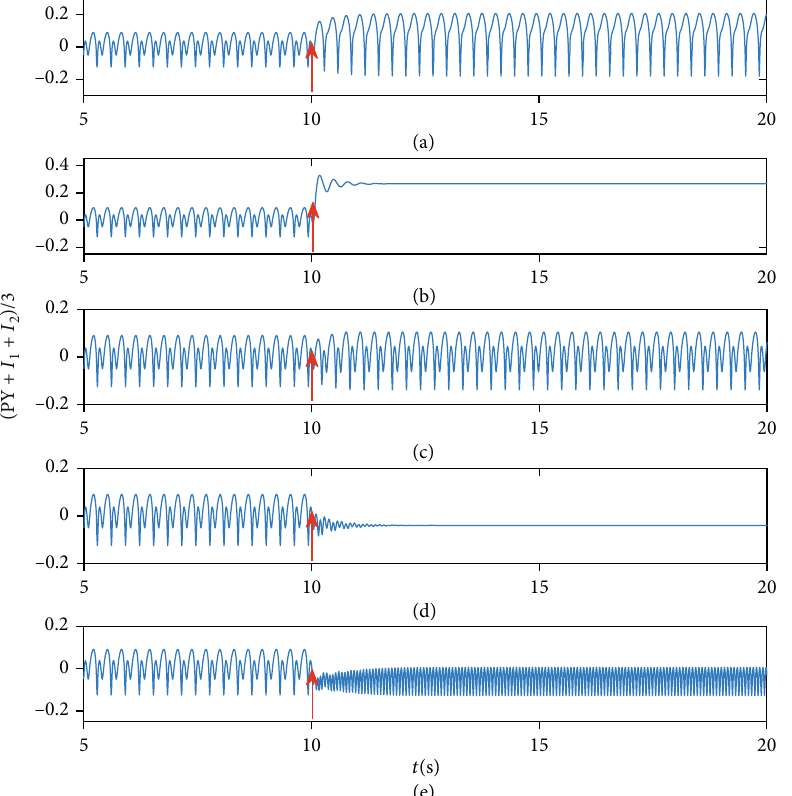
Figure 11: Transition behaviors under DBS acting on RE at t = 10 s, given by red arrows: (a) SWD to low-frequency clonic, A δ = 0 : 001 ; (b) SWD to high saturated state, A = 5 , δ = 0 : 002 ; (e) SWD to tonic, A A DBS behaviors by regulating the amplitude and pulse width of